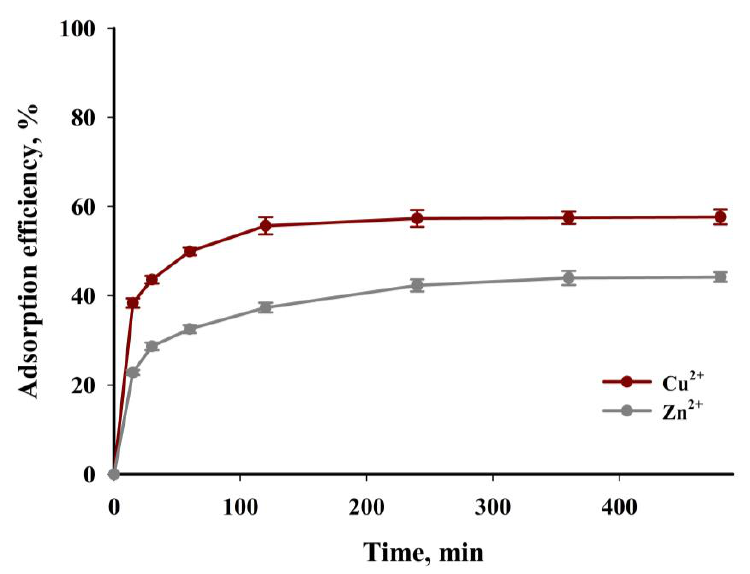
Figure 16. Adsorption efficiency as a function of time ( c = 300 mg·dm −3 , T = 40 °C, mass of adsorbent = 6.67 g·dm −3 , pH = 5). Table 8. The kinetic parameters of Cu 2+ and Zn 2+ adsorption process onto the SSB6 biochar. Kinetic